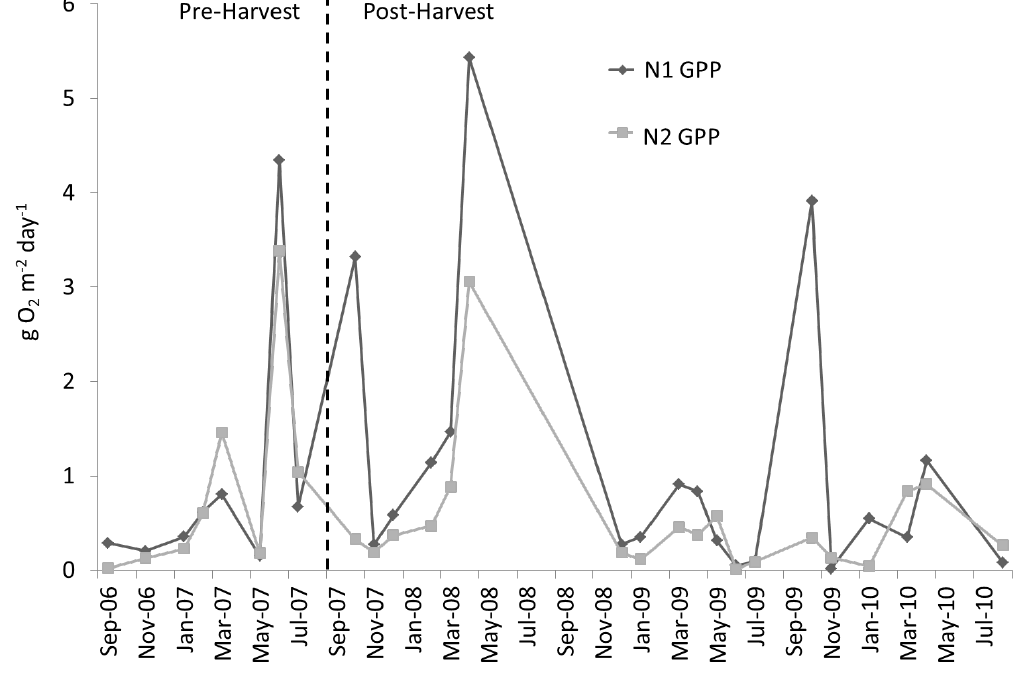
Figure 6. Time series of monthly averaged gross primary productivity ( GPP ; g O at N1 and N2 over the study period. Harvest is indicated by the vertical, dashed line.